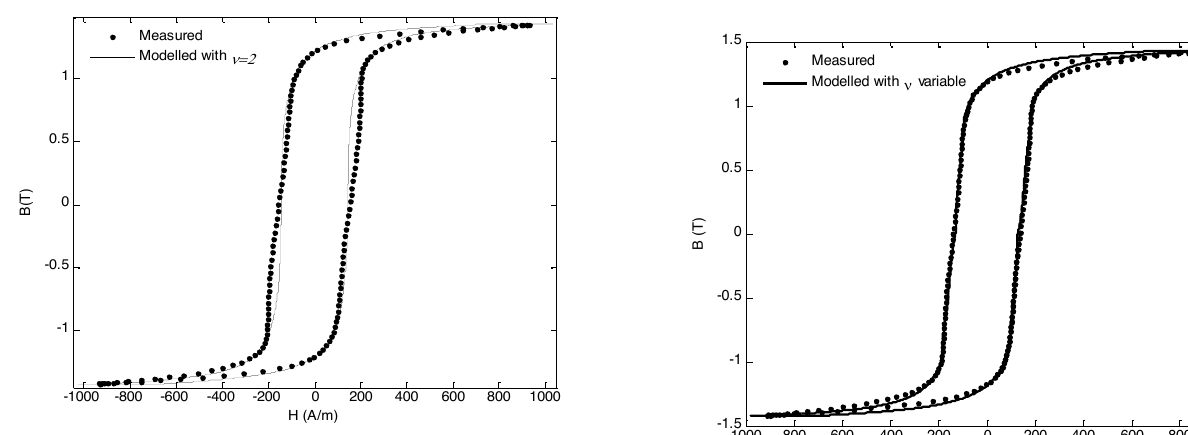
FIGURE 7. Modelled and measured hysteresis loops at 200 Hz with n